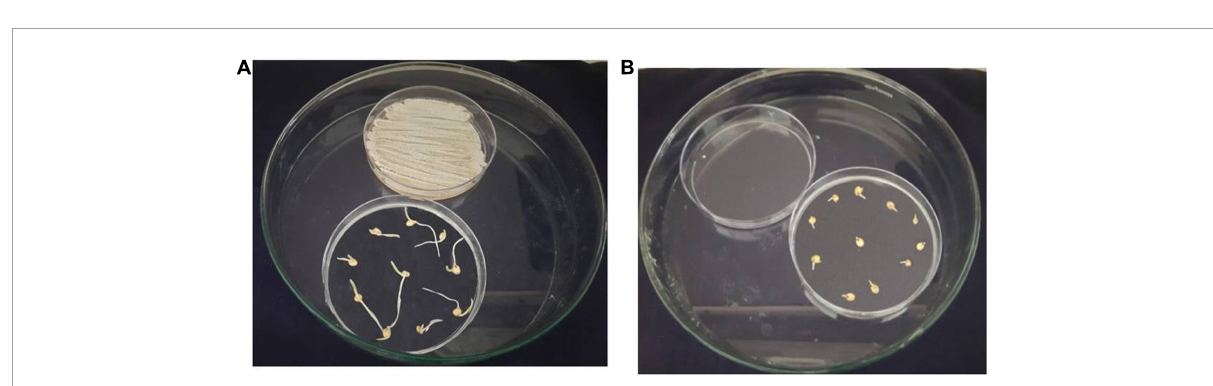
FIGURE7 Growth attributes of sorghum seedlings exposed to VOC of S. rochei . (A) Seeds exposed to volatiles of S. rochei ; (B) Seeds unexposed to volatiles of S. rochei